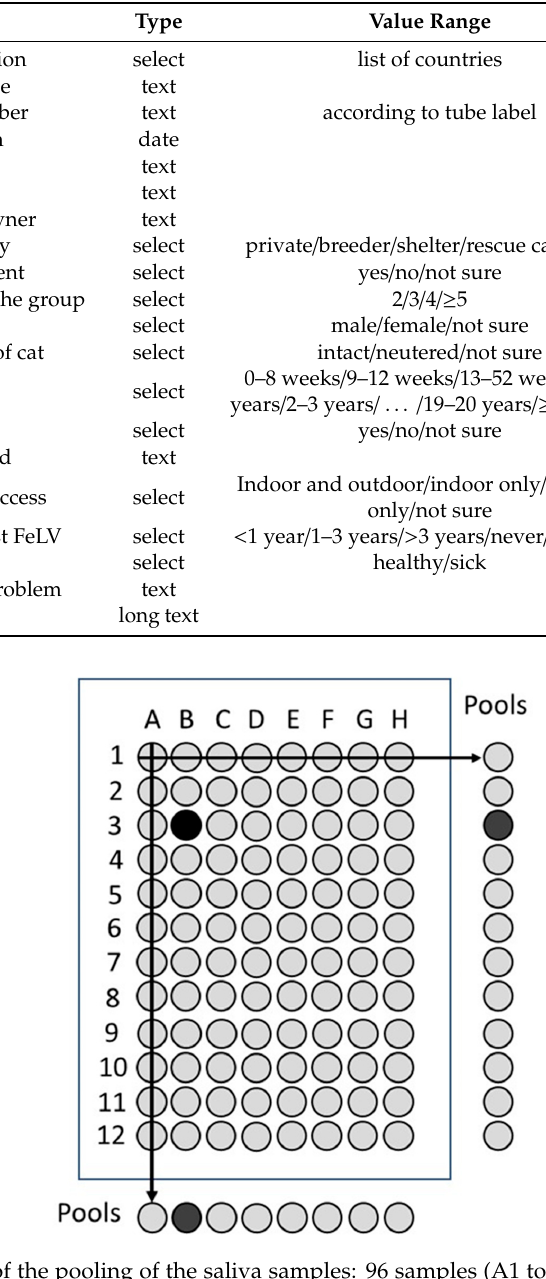
Figure A1. Schema of the pooling of the saliva samples: 96 samples (A1 to H12) were pooled to 20 pools. Each pool consisted of 200 µ L; either 8 × 25 µ L (horizontal pooling) or 12 × 16.7 µ L (vertical pools). After pooling, each sample was present in two pools. Example: If a sample is FeLV-positive (black circle, B3), two pools resulted in positive RT-PCR